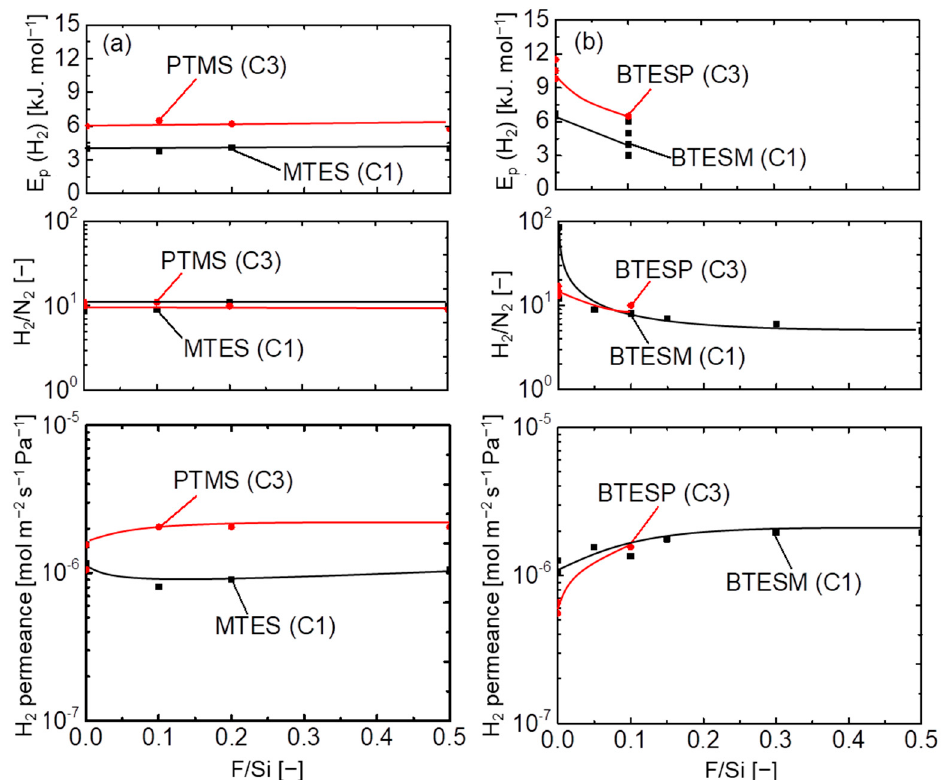
Figure 9. Effect of doped fluorine concentration on the network pore sizes of pendant– ( a ) and bridged–type ( b ) organosilica membranes calcined at 300–350 ◦ C under a N 2 atmosphere.